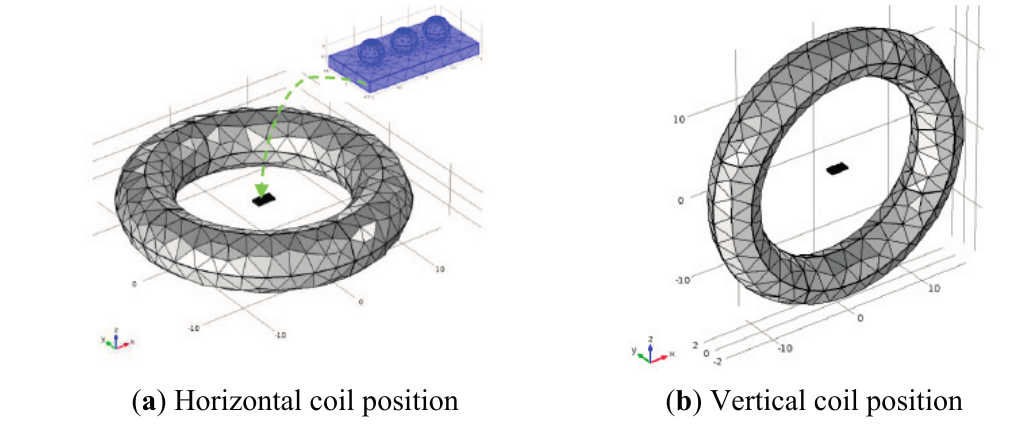
Figure 9. Different relative positions.